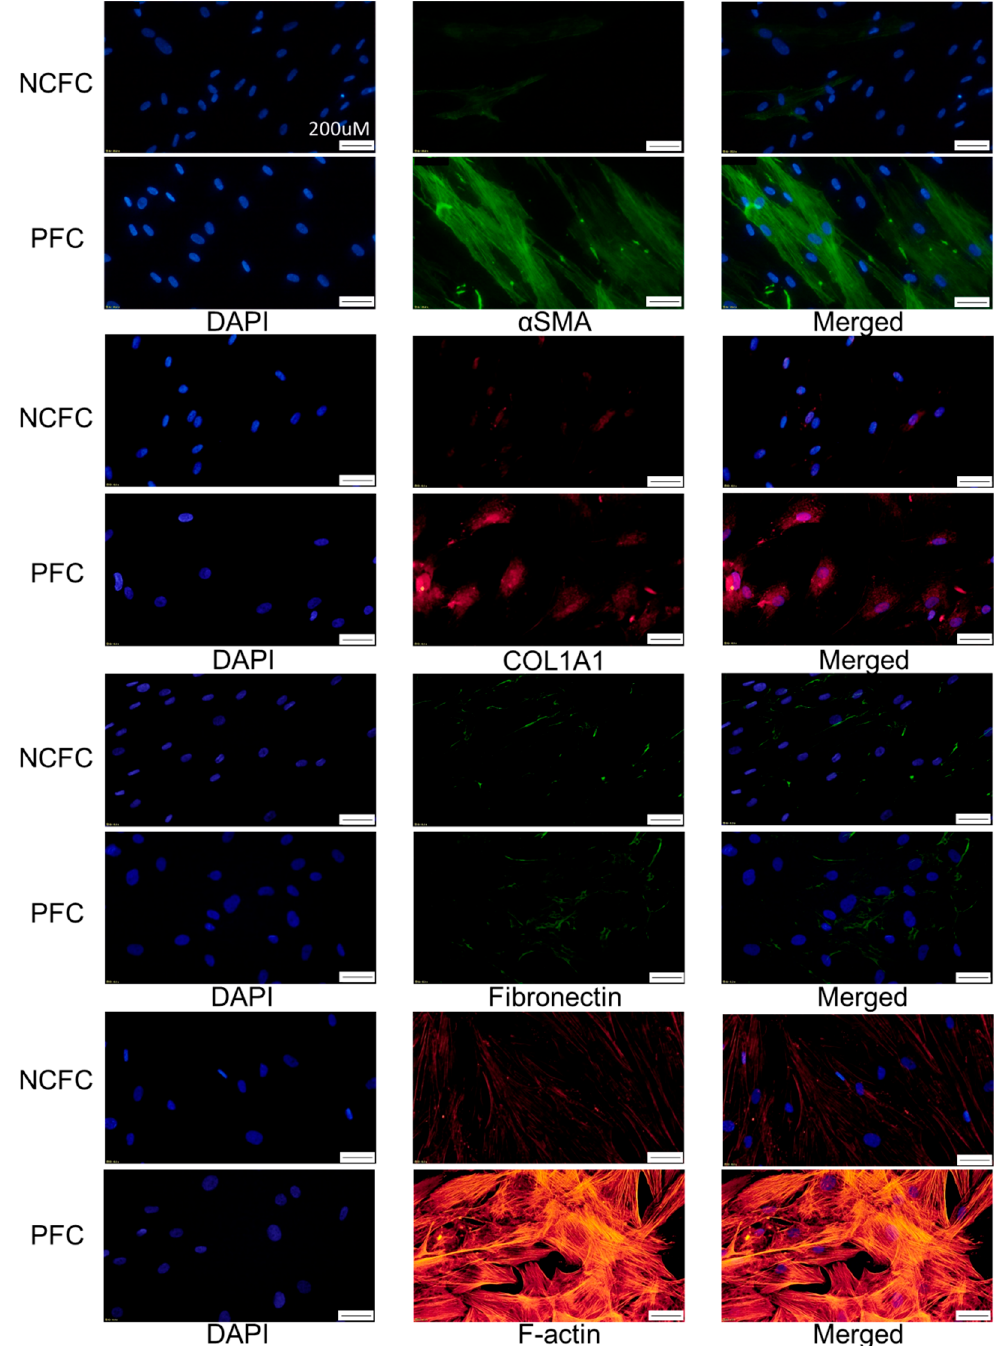
Figure 8. Immunocytochemistry of α -SMA (alpha-smooth muscle actin), COL1A1 (Collagen Type I Alpha 1 Chain), fibronectin, and F-actin in NCFCs and PFCs. The left panels show cells that were stained with DAPI. The middle panels show cells stained for either α -SMA, COL1A1, fibronectin, or F-actin. The right panels show a merged image. These components were upregulated in PFCs compared to NCFCs. Bar, 200 µm.